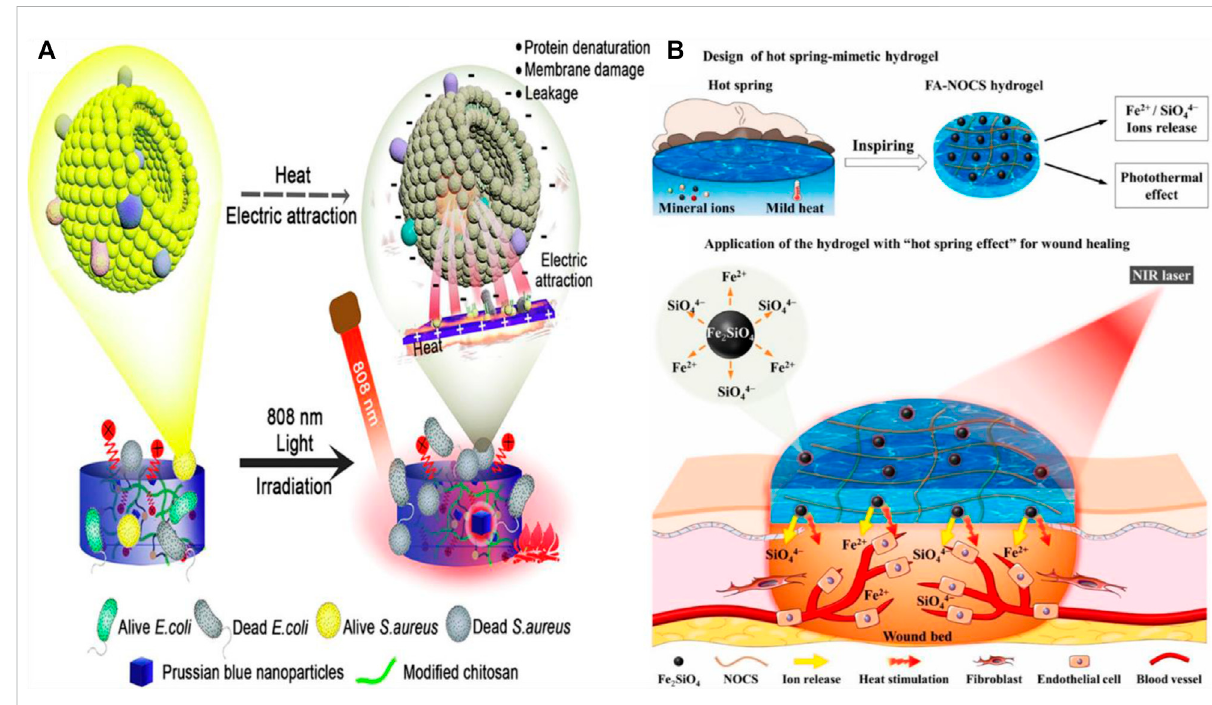
FIGURE 8 (A) Schematic of bactericidal action of hydrogel. Reproduced from ref. 26 with permission from 2020 Elsevier B.V. (B) Schematic diagram of application of bioactive photothermal hydrogel in wound healing. Reproduced from ref. 71 with permission from 2020 Elsevier